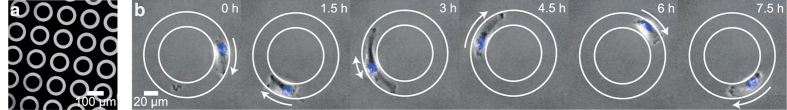
Cell migration in ring-shaped micropatterns.(a) Fluorescence image of the pattern consisting of labeled fibronectin (bright) and PLL-PEG (dark). (b) Time-lapse series of phase-contrast images of a MDA-MB-436 cell migrating along a ring-shaped lane. The fluorescently labeled nucleus is indicated in blue. Cell morphologies predominantly fall into two classes: asymmetrically polarized cells with a single lamellipodium at the leading edge and the nucleus located at the posterior end, and elongated cells with two, symmetrically positioned lamellipodia.